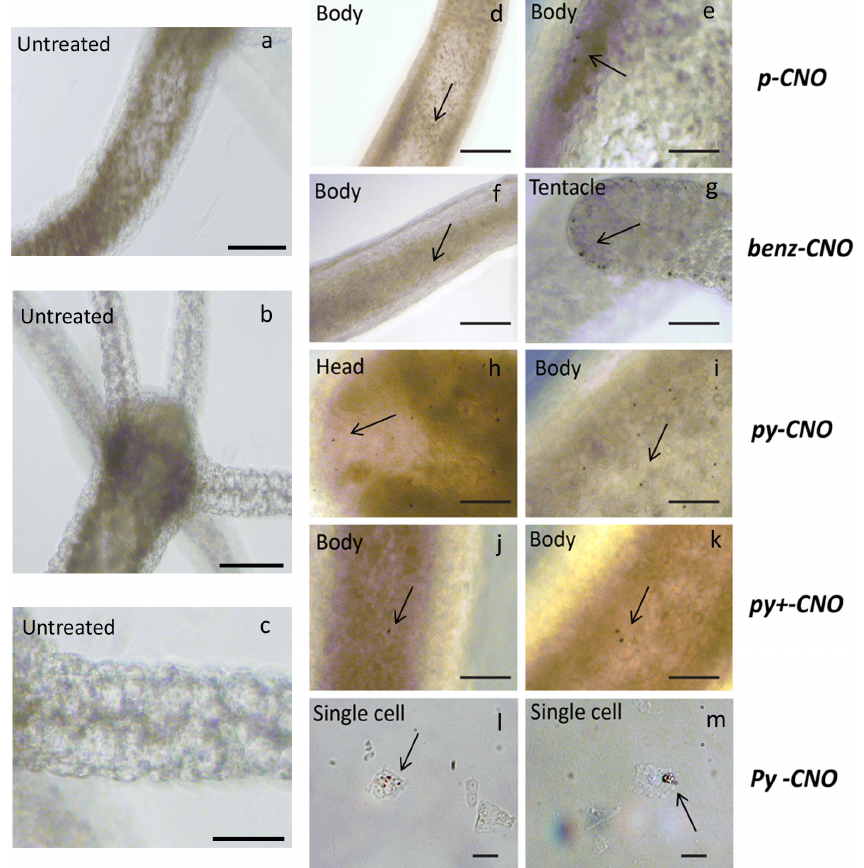
Figure 4. In vivo uptake and biodistribution of CNO nanoparticles in Hydra . ( a – c ) Bright field images of a living untreated polyp. Scale bar: 200 µm. ( d – m ) All different types of